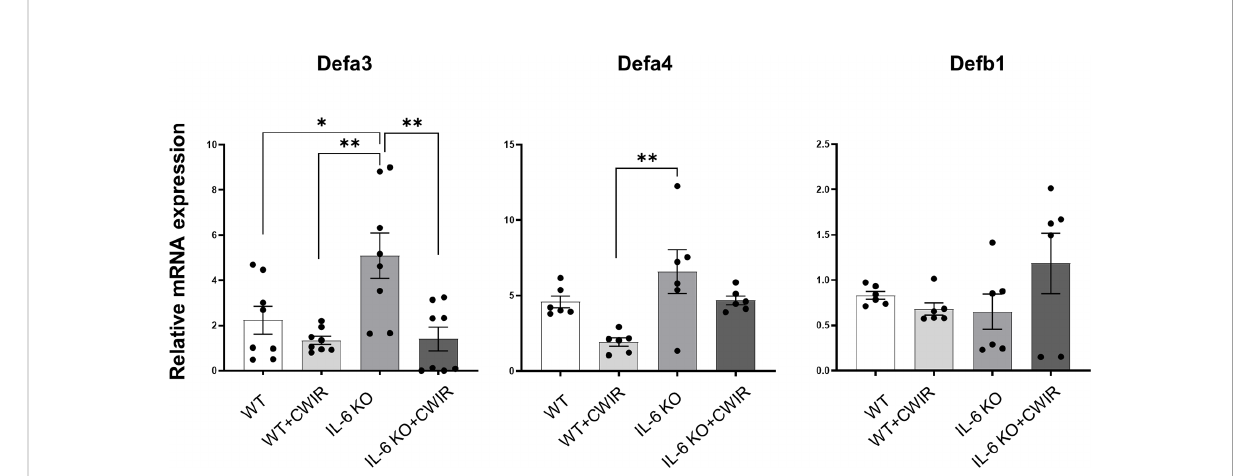
FIGURE 5 IL-6 KO alleviated CWIR-mediated enhanced defensins expression in the jejunum. Relative mRNA levels of Defa3 , Defa4 , and Defb1 among groups. Data analysis was performed by two-way ANOVA with the Tukey post-hoc test. N=6-8, * P <0.05, ** P